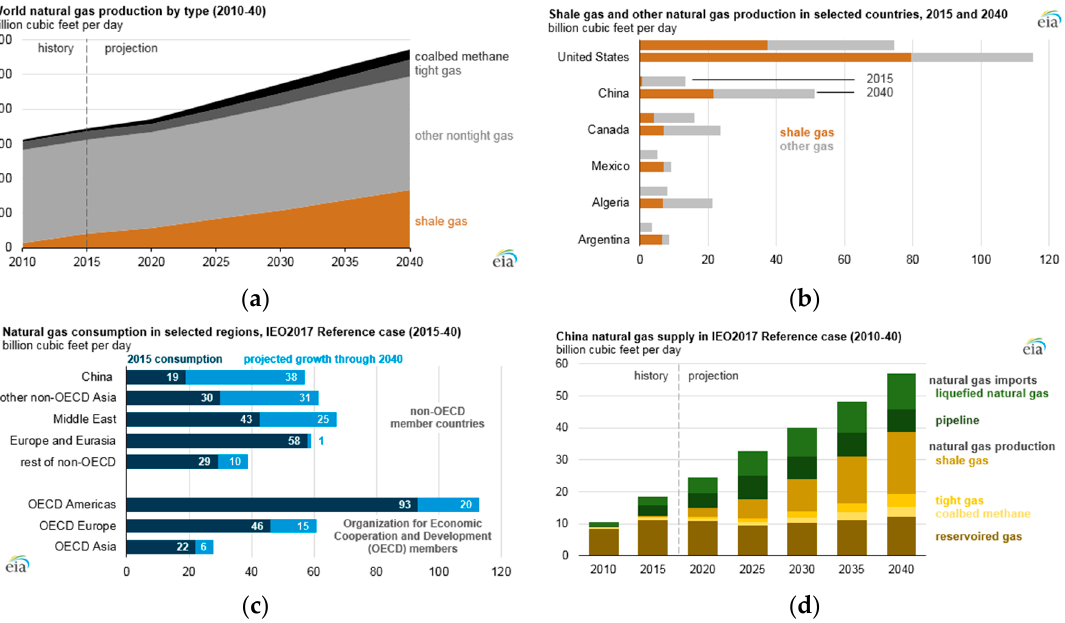
Figure 1. Current and predicted situations of shale gas resources in different countries or regions (from EIA). ( a ) Natural gas production by type. ( b ) Shale gas production in different countries. ( c ) Natural gas consumption in different regions. ( d ) Natural gas supply by type in China.